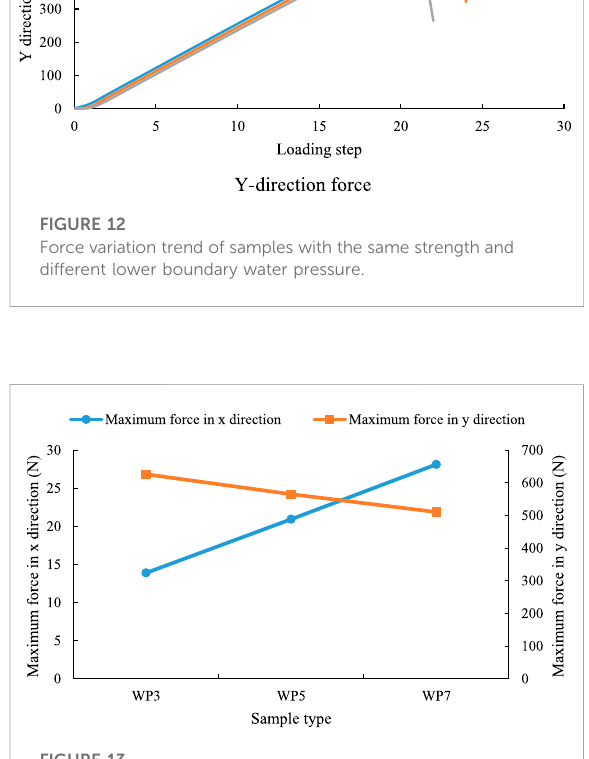
FIGURE 13 Force comparison curve of samples with the same strength and different lower boundary water pressure.